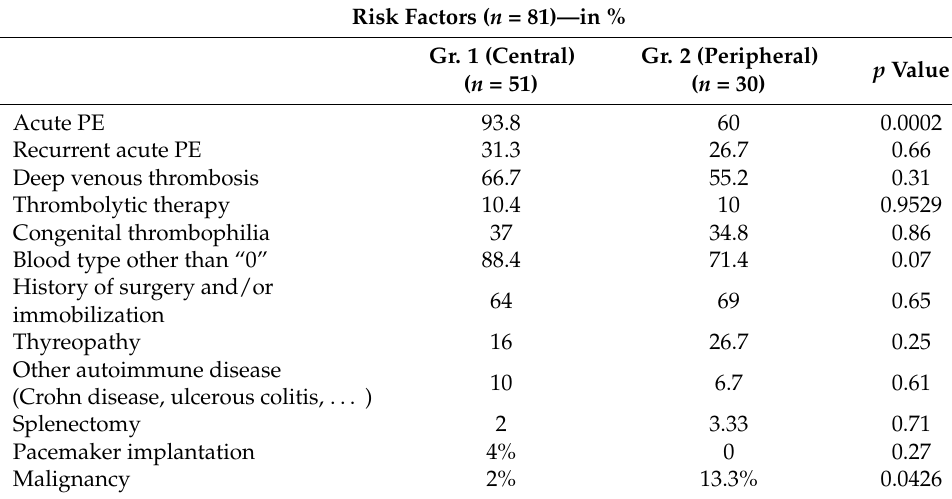
Table 2. Risk factors, comparison of Group 1 vs. Group